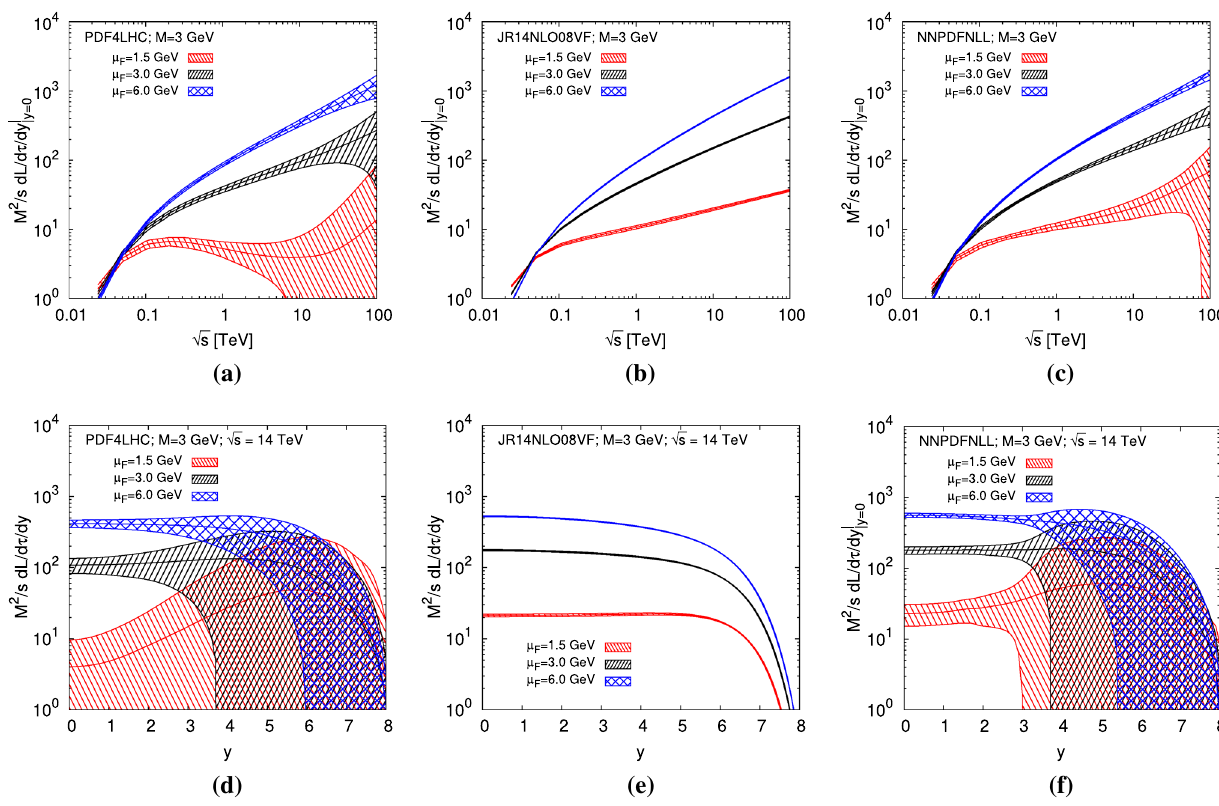
√ Fig. 5 τ 0 ∂ L ∂τ∂ s and at y = 0 (top) and τ 0 ∂ L ∂τ∂ as a function of energy y PDF4LHC15_nlo_30 (left), JR14NLO08VF (middle) and NNPDF31sx_nlonllx_as_0118 (right)) for 3 μ F values (0 . 5 M , M and 2 M